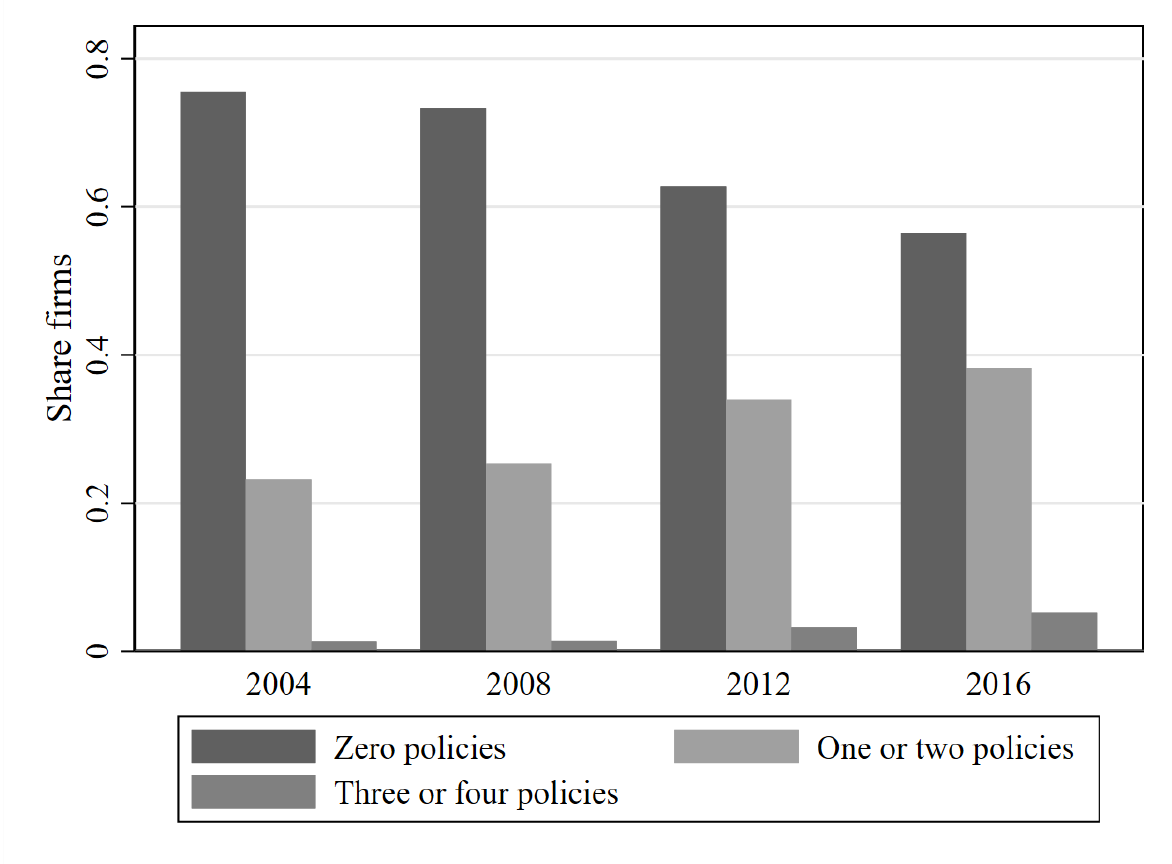
Figure 2: Share of firms with different numbers of policies by year. Notes: The number of observations is 5,660 firm-years from 1,415 firms. Source: Own calculations using the LIAB QM2